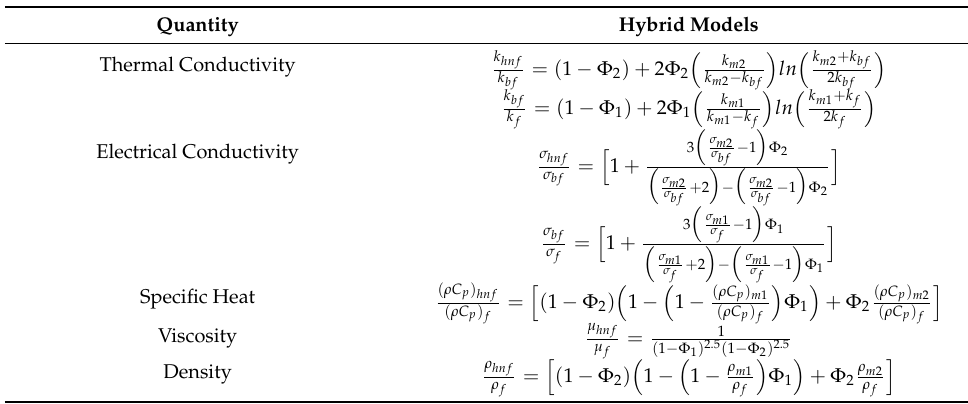
Table 2. Mathematical relations for the computation of physical properties of HN